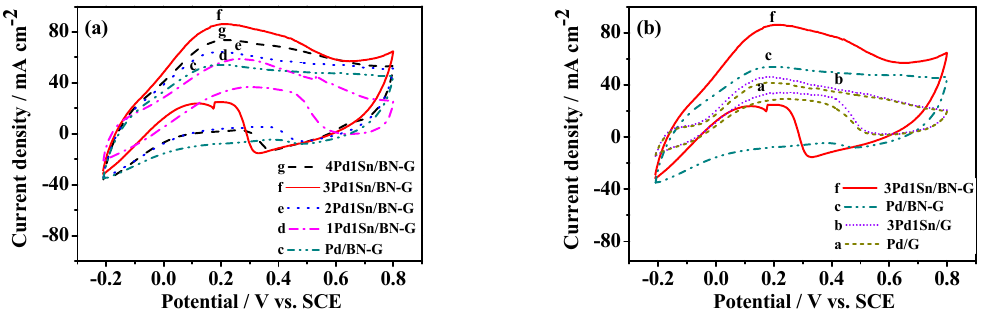
Figure 4. Cyclic voltammograms in 1 M HCOOH + 0.5 M H 2 SO 4 solution for ( a ) xPdySn/BN-G catalysts and Pd/BN-G, ( b ) 3Pd1Sn/BN-G and 3Pd1Sn/G, Pd/BN-G and Pd/G, scan rate: 50 mV s − 1 .